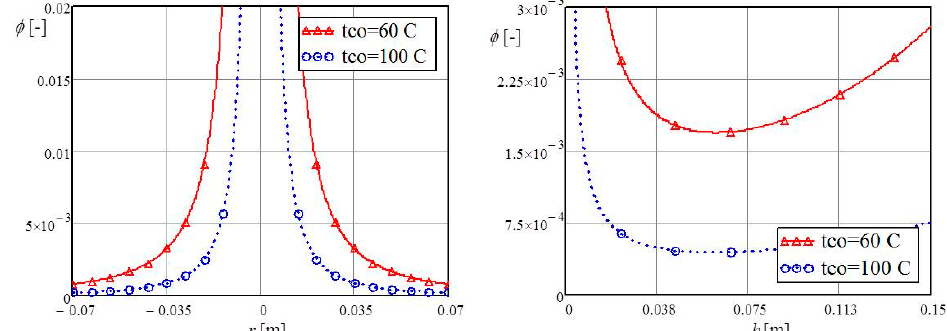
Figure 7. Irreversibility distribution ratio of the individual influence of the bottom and the vertical annular channel.